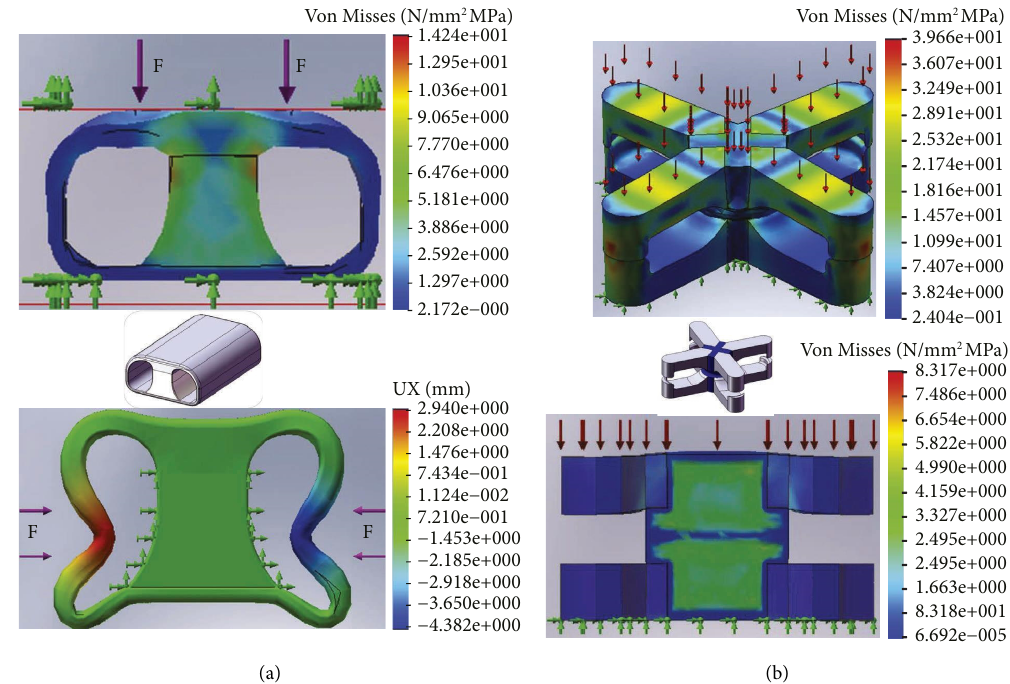
Figure 5: Finite element analysis of two sandwich-type nucleus implants. Implant deformations in the x -axis